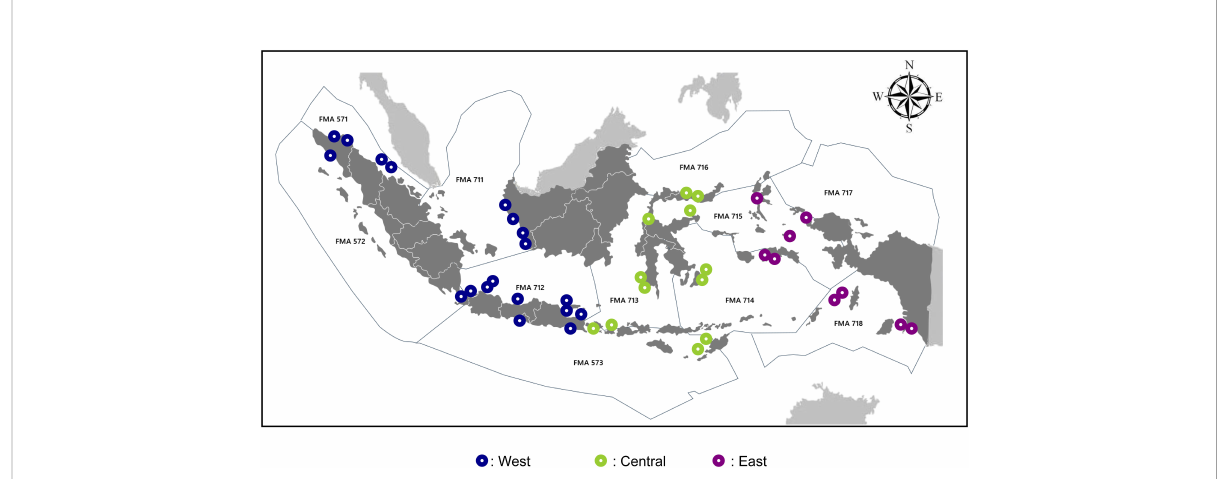
FIGURE 1 eDNA seawater sampling sites in coral reefs across Indonesia by region (West n = 19, Central n = 12 and East n = 9) and fi sheries management area